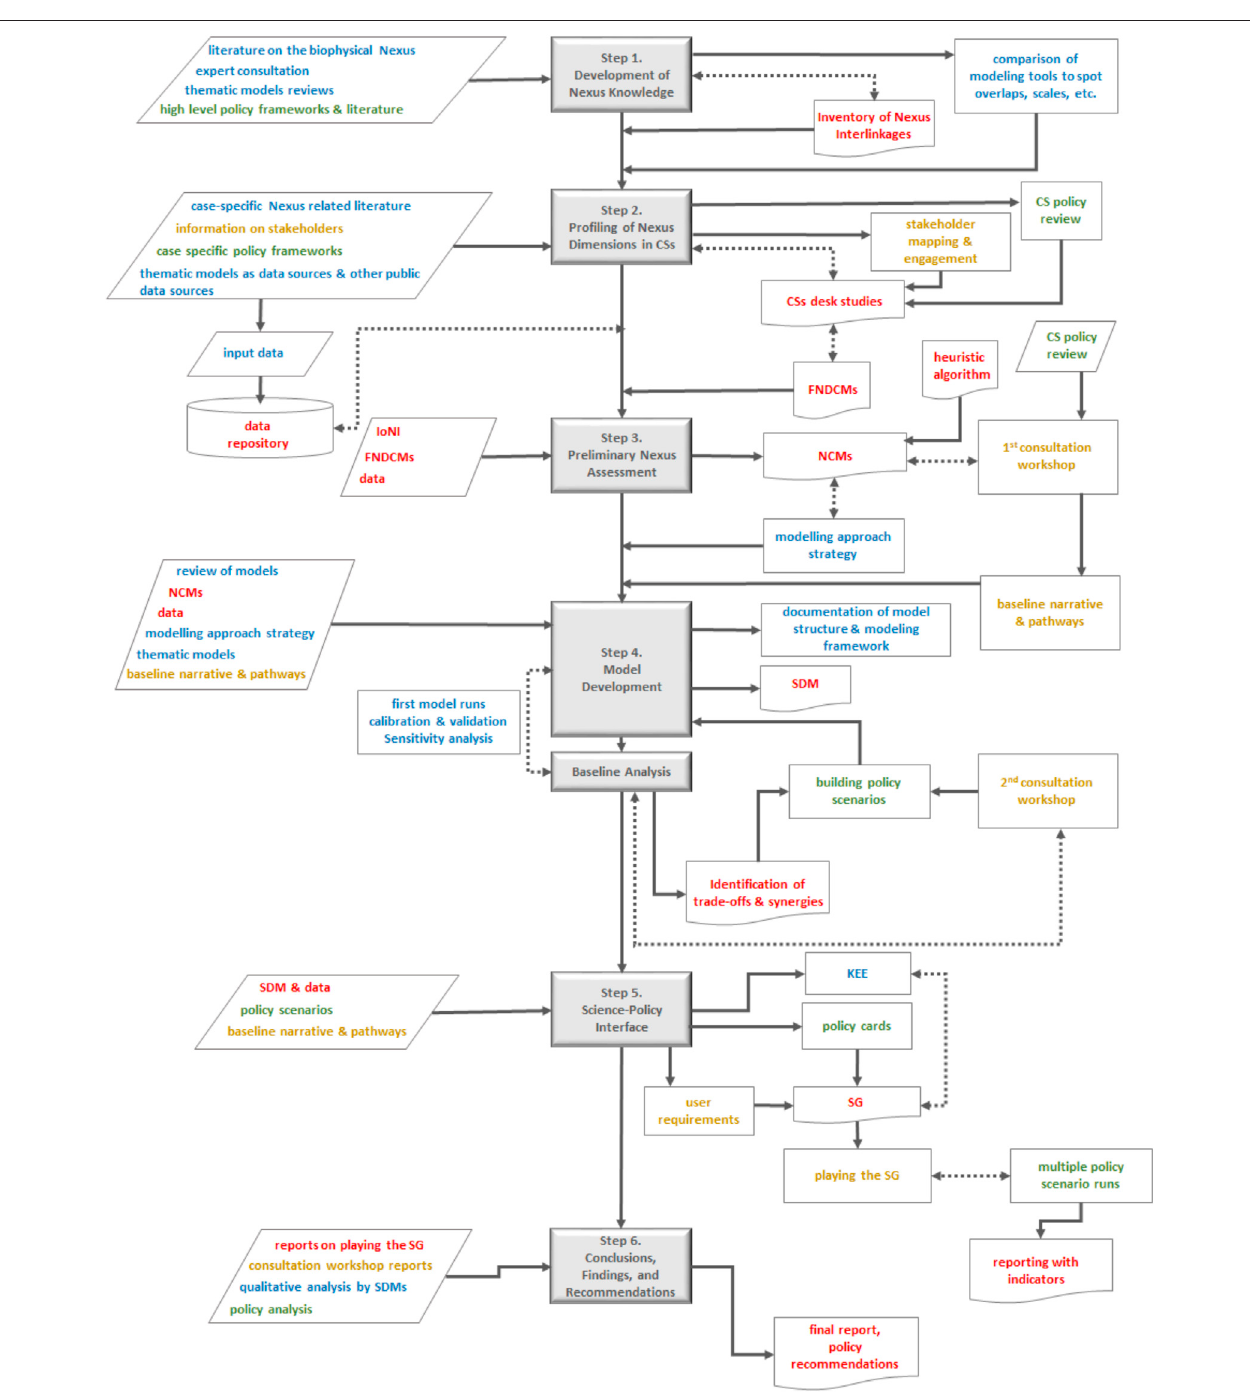
FIGURE3 | Overview ofthe SIM4NEXUS approach. The work fl owsrelated to the biophysical analysisthread are noted with blue, tothe policy analysis thread with green, to the socio-economic analysis with yellow, and major outputs with red. Acronyms: CM — conceptual maps; FNDCMs — Fragmented Nexus Dimensions Conceptual Maps; IoNI — Inventory of Nexus Interlinkages; NCMs — Nexus Conceptual Map; SDM — System Dynamics Model; SG — Serious Game; KEE — Knowledge Elicitation Engine.